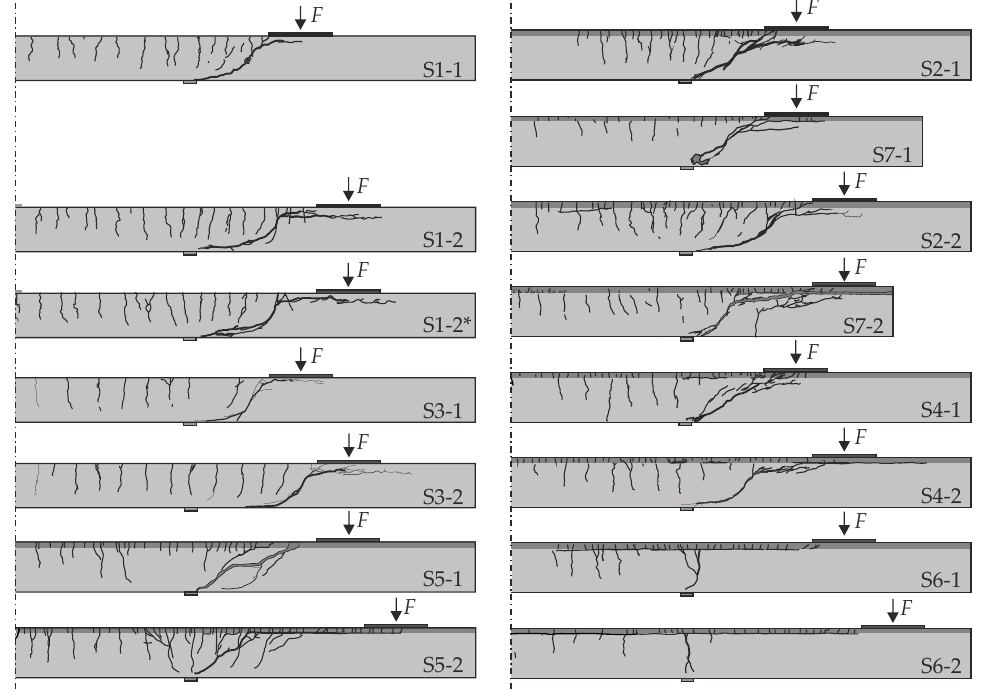
Figure 11. Crack patterns of static tests on specimens S1 to S7.